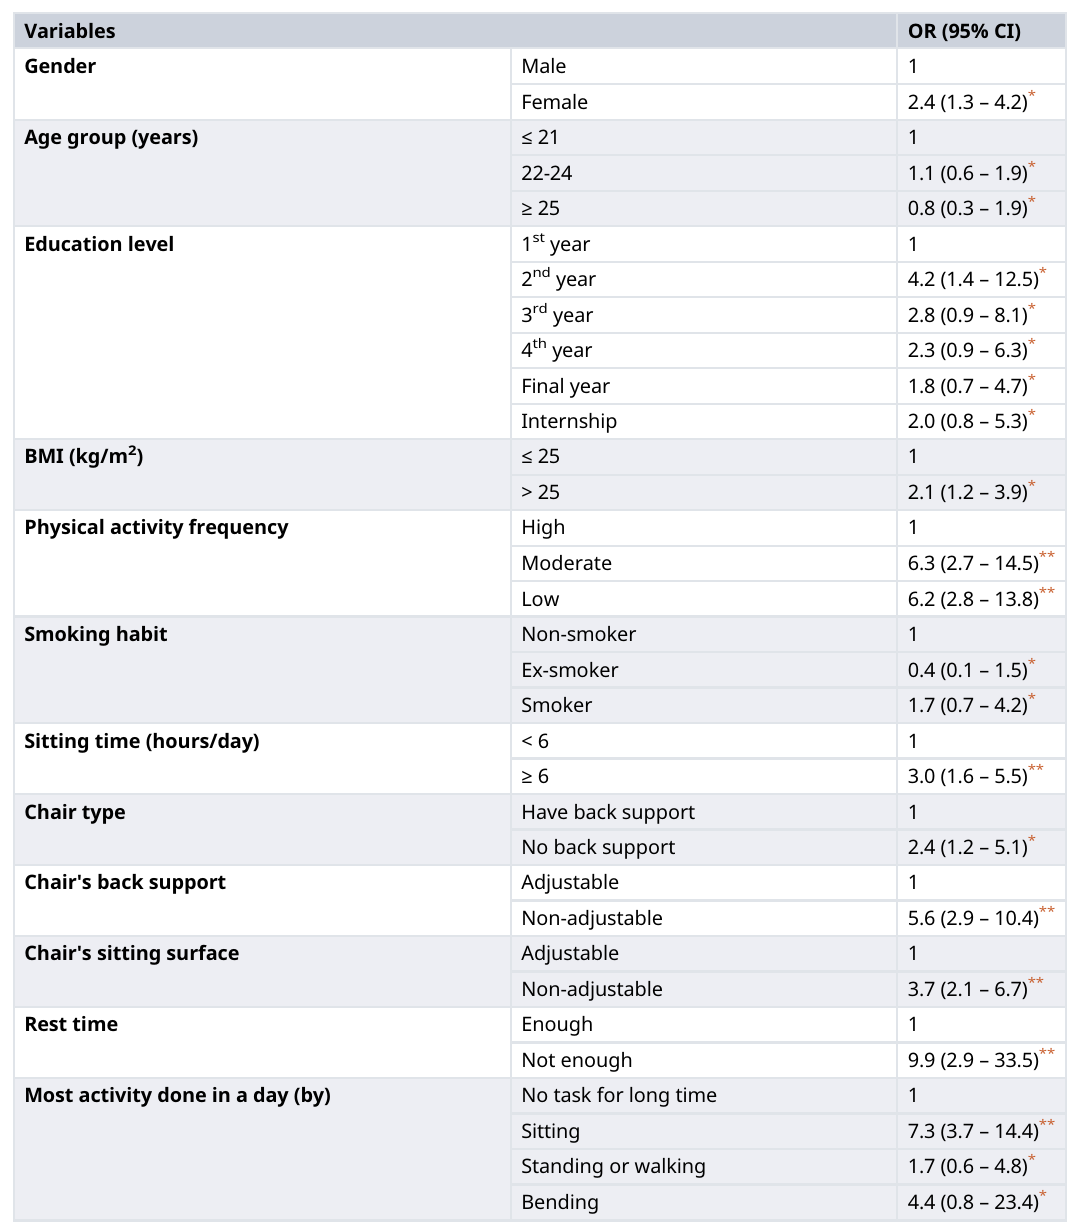
Table 3. Logistic regression analysis of factors associated with low back pain (n =